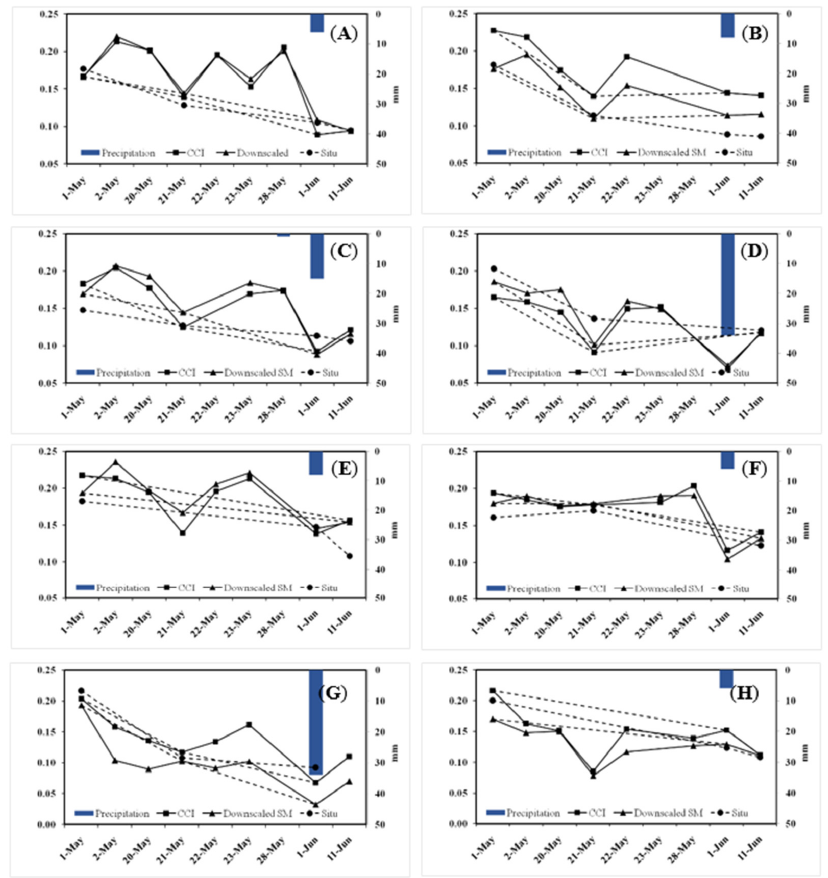
Figure 6. Comparisons of the time series curves of the original CCI SM data (cm 3 /cm 3 ), in situ SM data (cm 3 /cm 3 ), and downscaled SM data (cm 3 /cm 3 ) at eight sites ( A – H ), respectively, above three valid in situ observations selected). The three or four values of in situ SM and the corresponding original CCI SM and the downscaled SM are connected by dotted lines, respectively. The nine values of the original CCI SM andthe corresponding downscaled SMare connected by solid lines. The corresponding precipitation values are presented in bar charts. Table 3. Statistical comparisons of average absolute difference (AAD) valuesbetween the original CCI SM data orthe downscaled CCI SM dataand in situ SM dataon1 May, 21 May, 1 June, and 11 June. The lower AAD values are noted in bold.